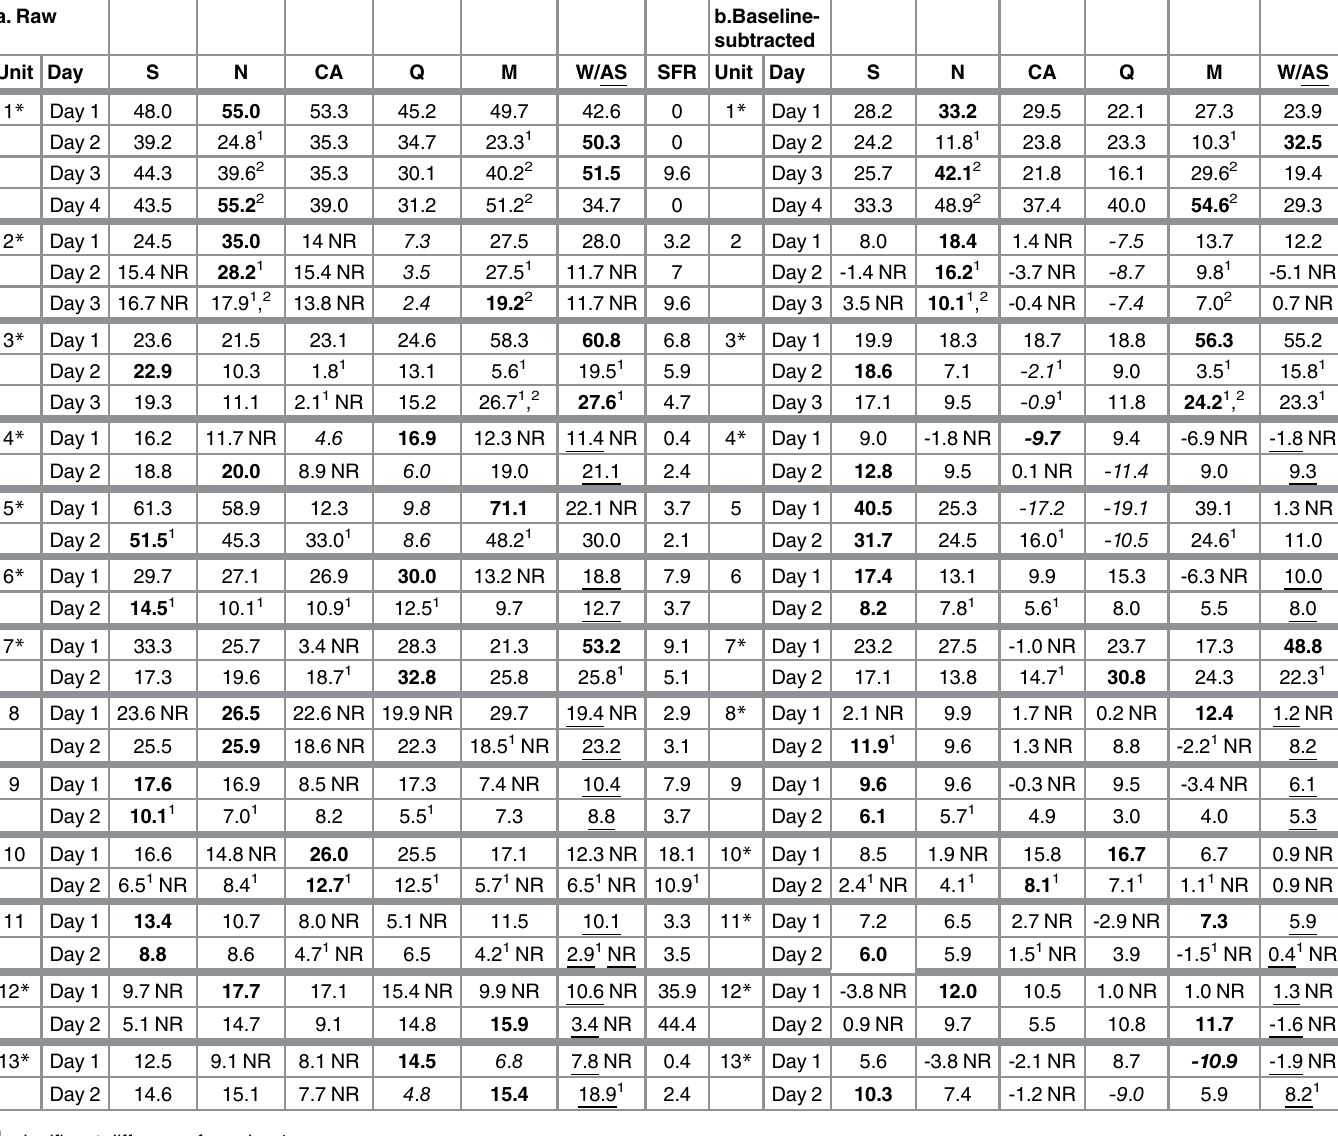
Table 2. Taste response magnitudes in spikes per sec (sps) in the PbN for taste stimuli of multiday recordings that met the “ same unit ” criterion. a.